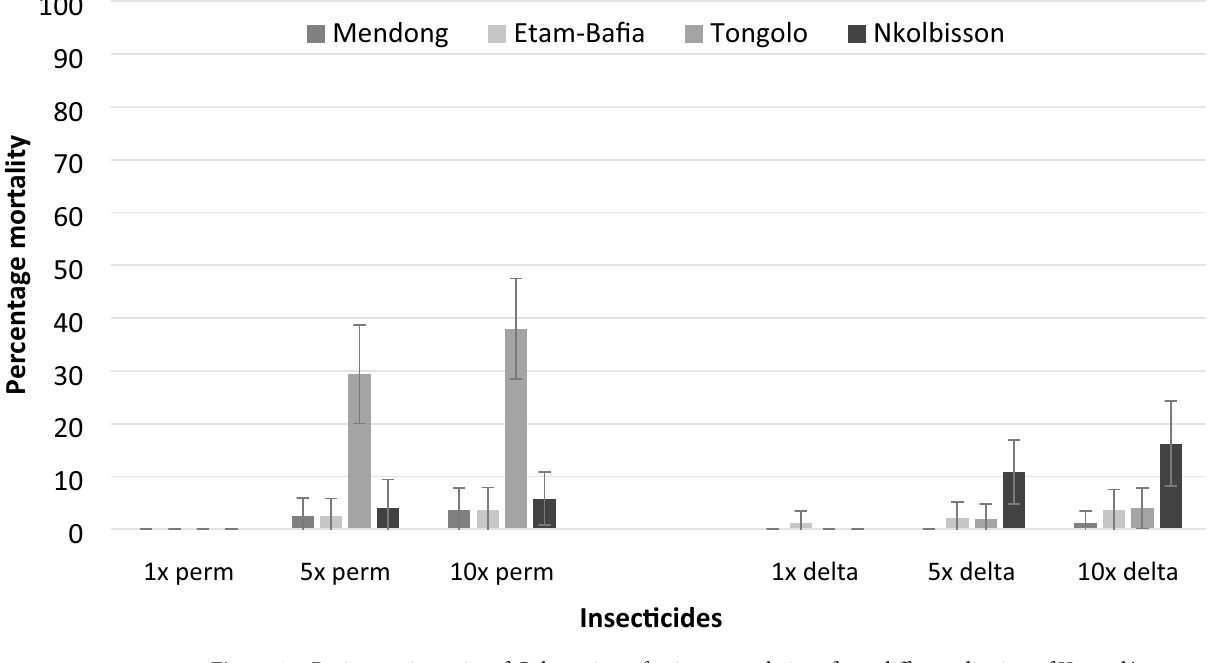
Figure 1 . Resistance intensity of Culex quinquefasciatus populations from different districts of Yaoundé exposed to different concentrations (1 ×, 5 × and 10 ×) of permethrin and deltamethrin. Error bars represent 95% confidence intervals. Perm = permethrin, delta = deltamethrin.